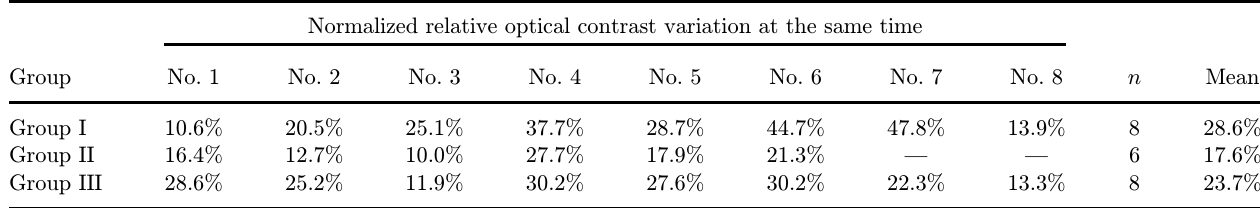
Table 1. Normalized relative optical contrast variation at one time point in mouse brain for Group I, Group II and Group III. Normalized relative optical contrast variation at the same time